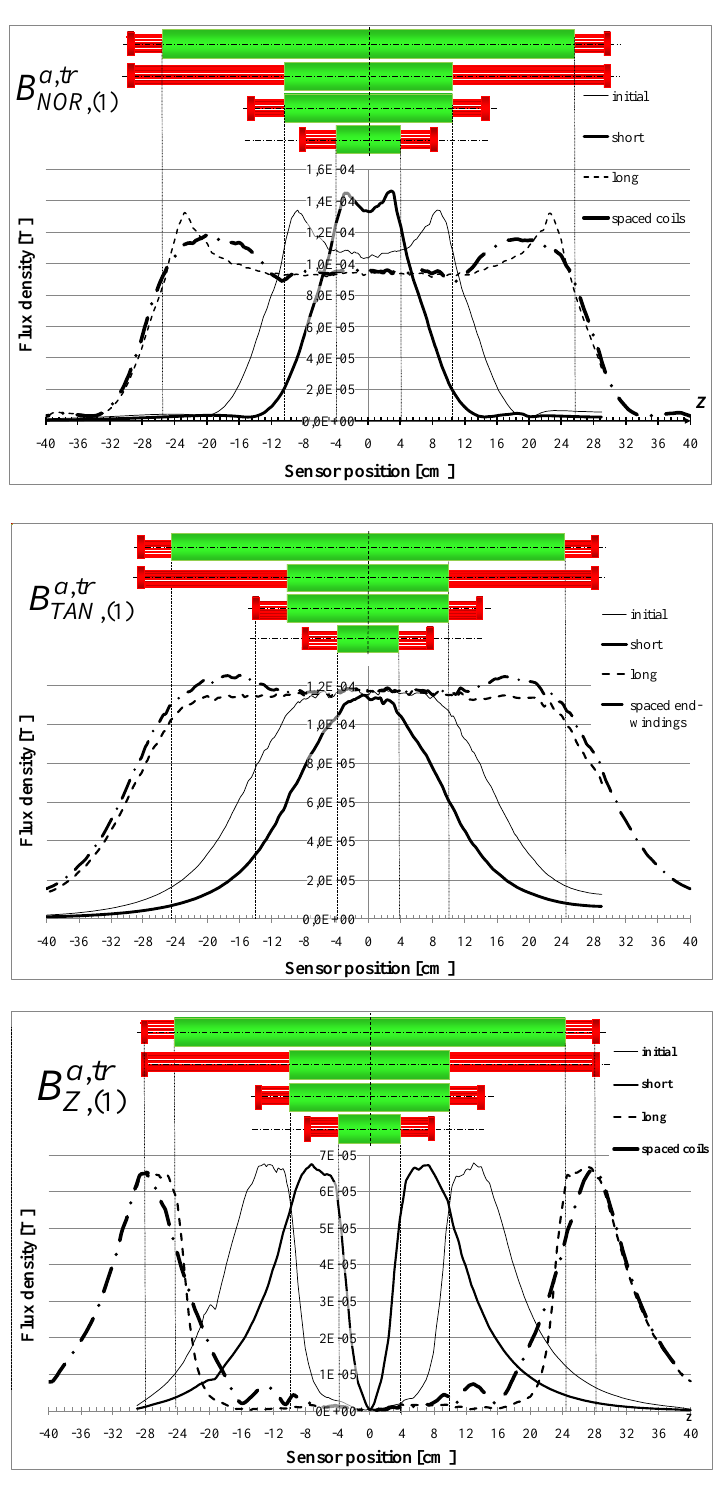
, tra and tra variations with Z B , B , B , NOR )1(, TAN )1(, Z )1(,